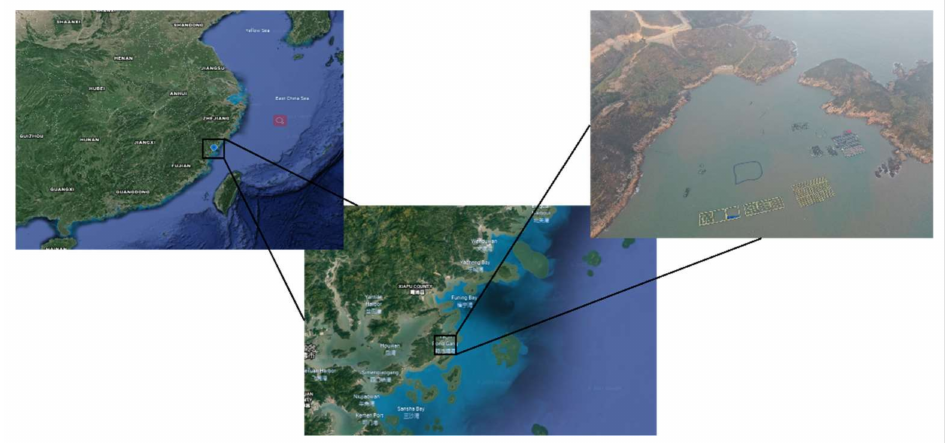
Figure 10. Picture of the mariculture platform on the coast of